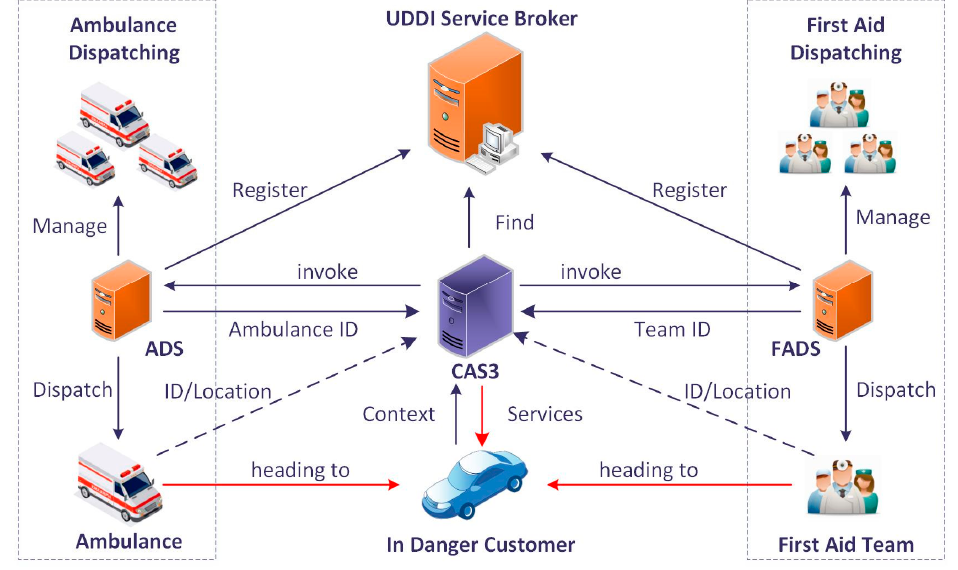
Figure 7. The invocation of selected services.